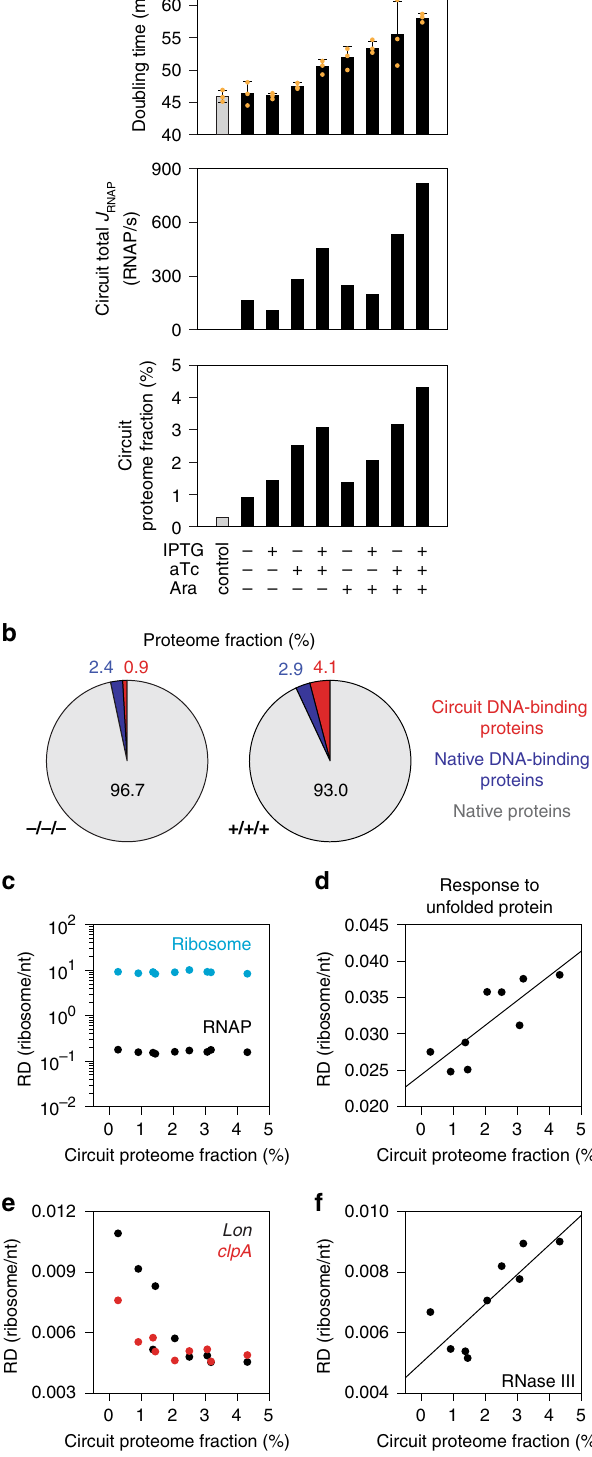
explain these differences, including the repressor af fi nities and